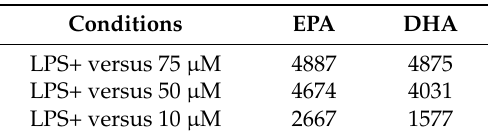
Table 1. Differentially expressed genes in lipopolysaccharide (LPS)-stimulated macrophages